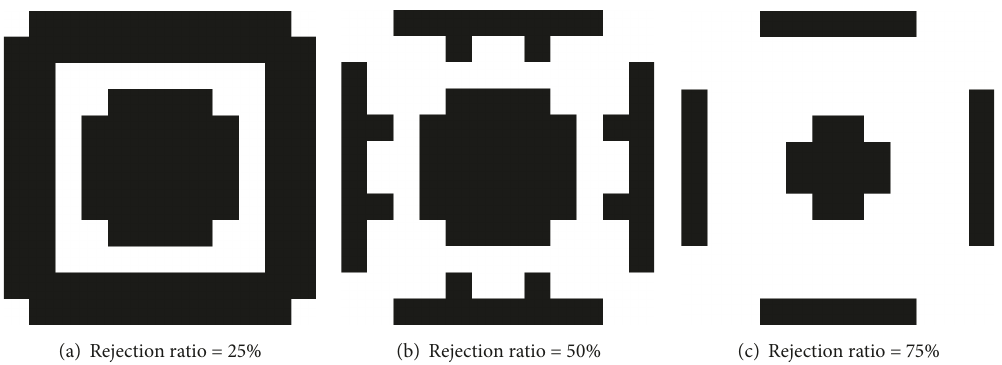
Figure 8: Optimal CLD layouts obtained using ESO under different rejection ratios for second BC.